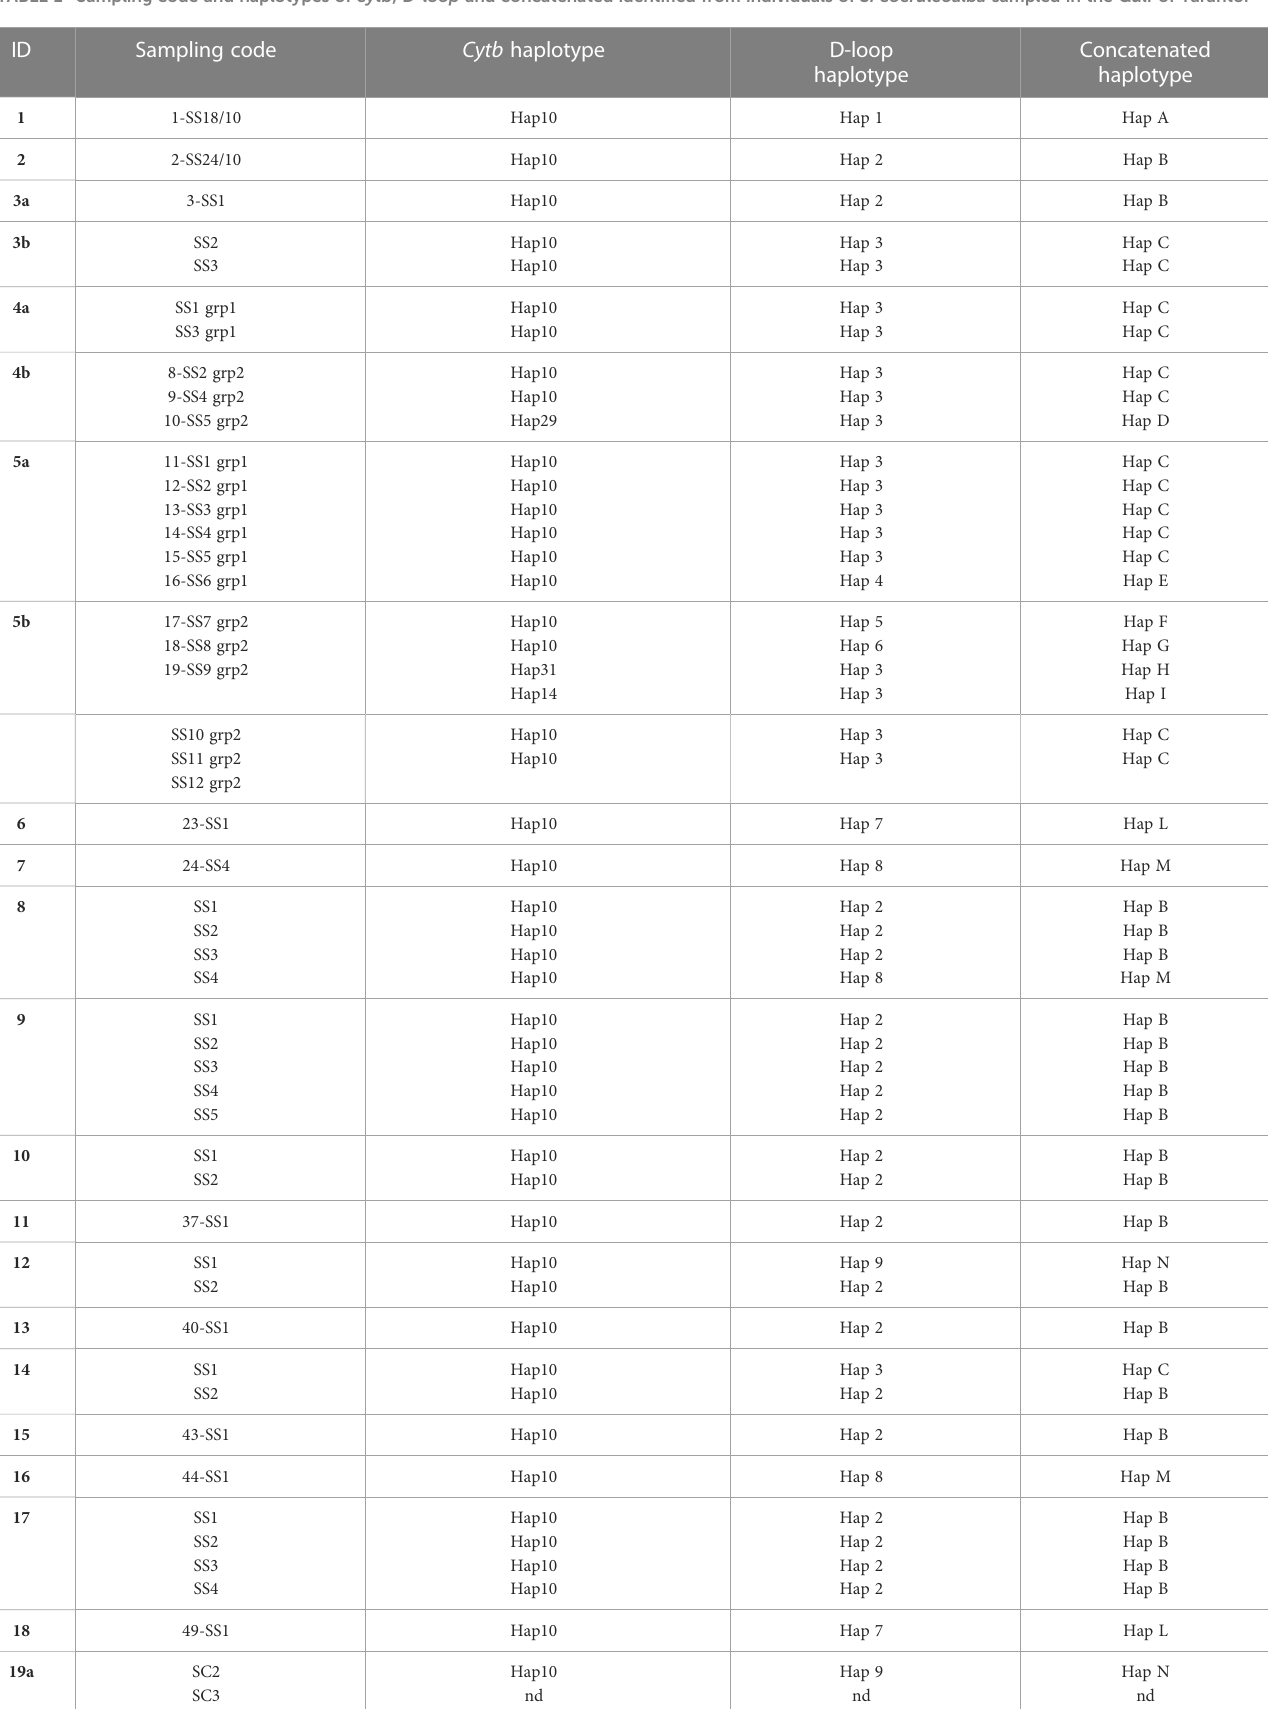
TABLE 1 Sampling code and haplotypes of cytb , D- loop and concatenated identi fi ed from individuals of S. coeruleoalba sampled in the Gulf of